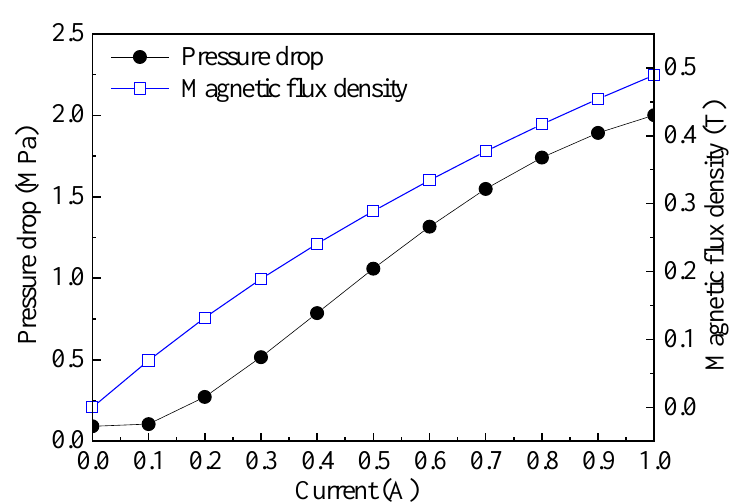
Figure 12. Magnetic flux density and pressure drop at different current.